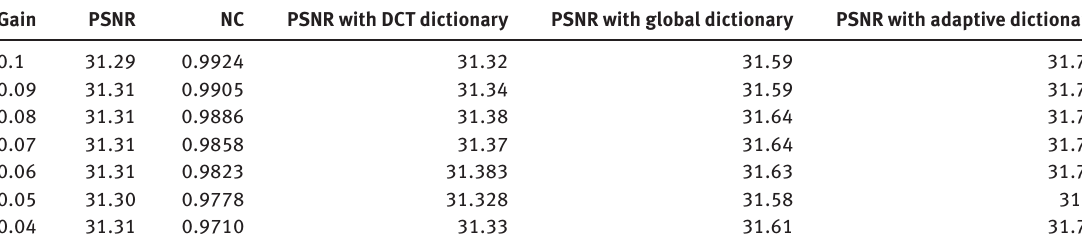
Table 3: Performance at Different Gain.